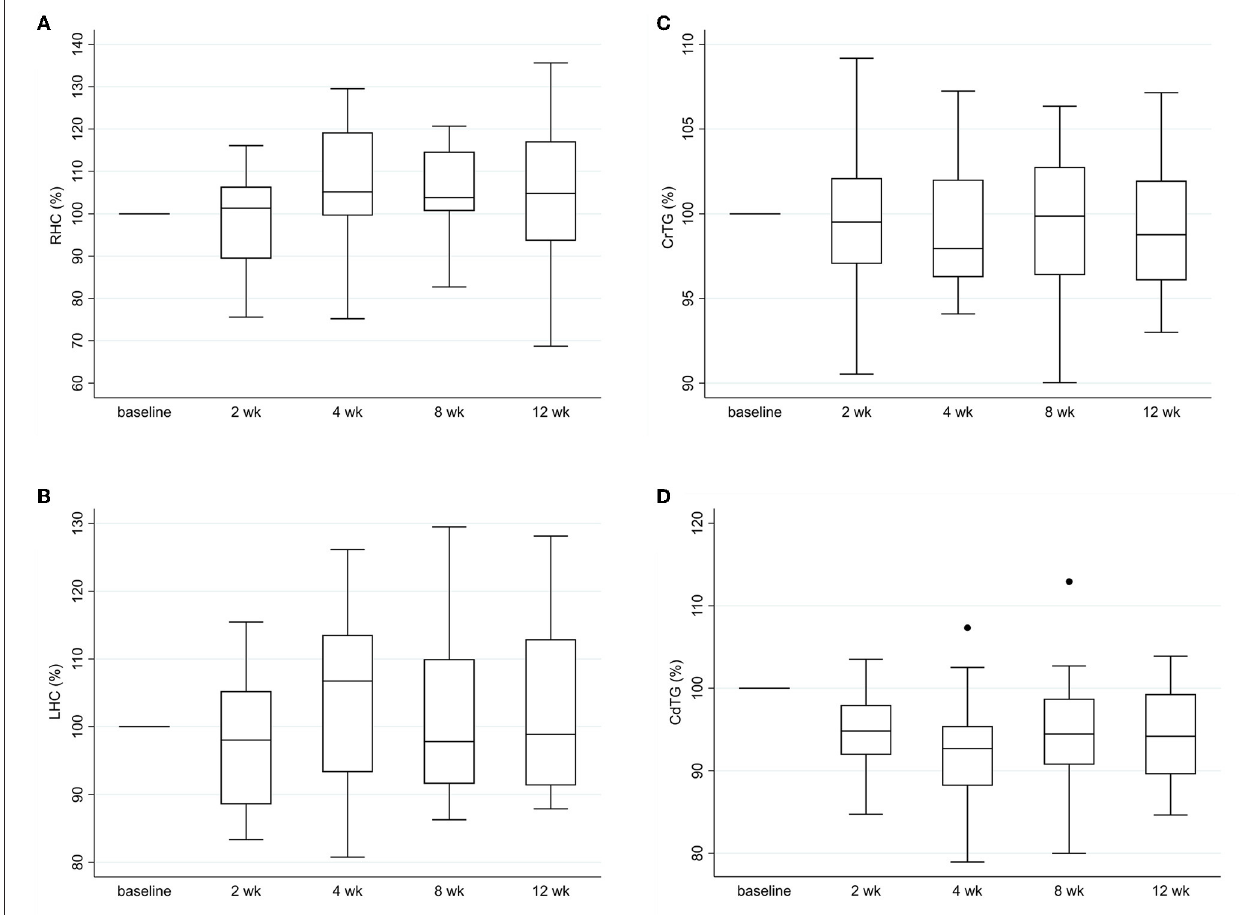
FIGURE 3 | Trunk and limb circumference measurements over time. (A) right thigh girth, (B) left thigh girth, (C) cranial trunk girth and (D) caudal trunk girth for each study visit as a percentage of baseline values. RHC: right hind limb circumference, LHC: left hind limb circumference, CrTG: cranial trunk girth, CdTG: caudal trunk